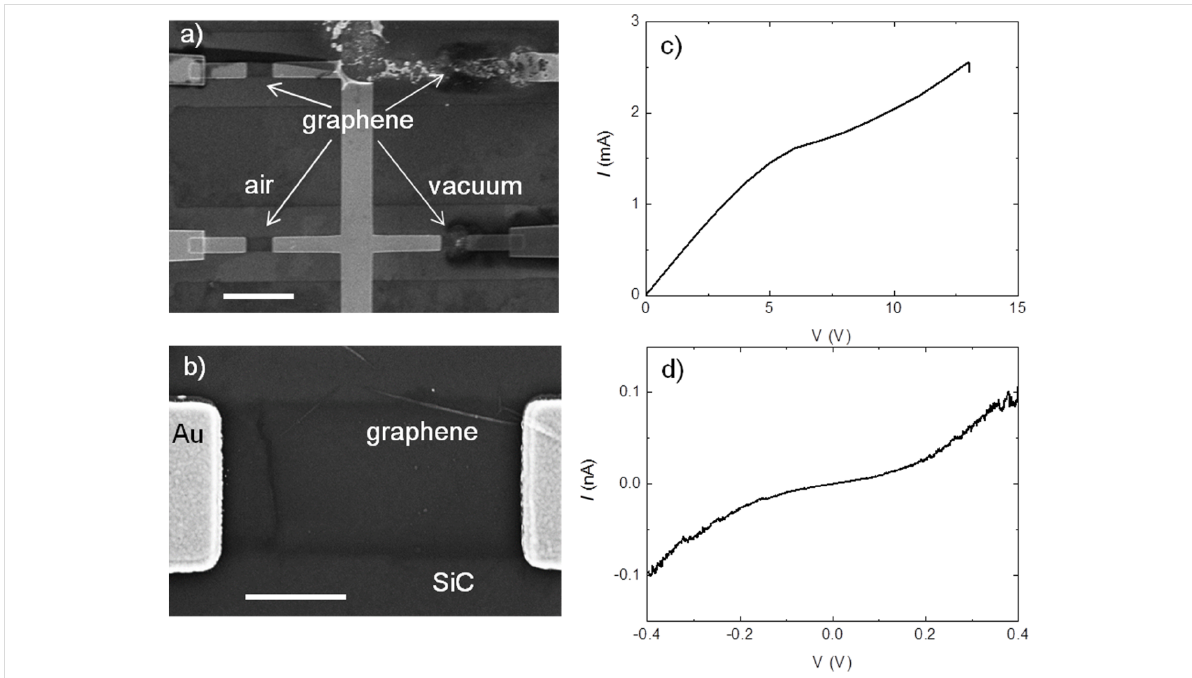
Figure 4: a) SEM image of epitaxial graphene devices after the EB process in air (left) and under vacuum (right). The scale bar is 5 µm. b) Magnification of the open gap in an air-processed device. Scale bar is 1 µm. c) I – V curve recorded for a typical electroburning (EB) process in air. d) Example of an I – V measurement after the EB process in air (no current is measured in the I – V when the EB process is performed under vacuum).